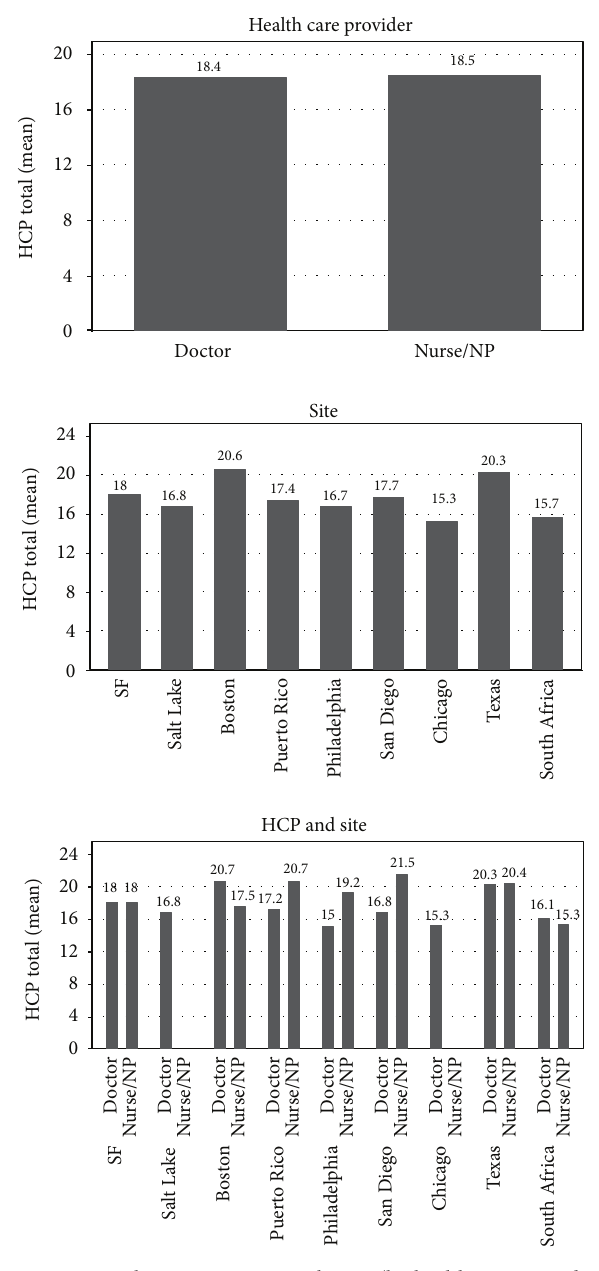
Figure 1: Baseline engagement with care (by health care Provider, site, and provider/site). Engagement with care is scaled such that lower scores denote better